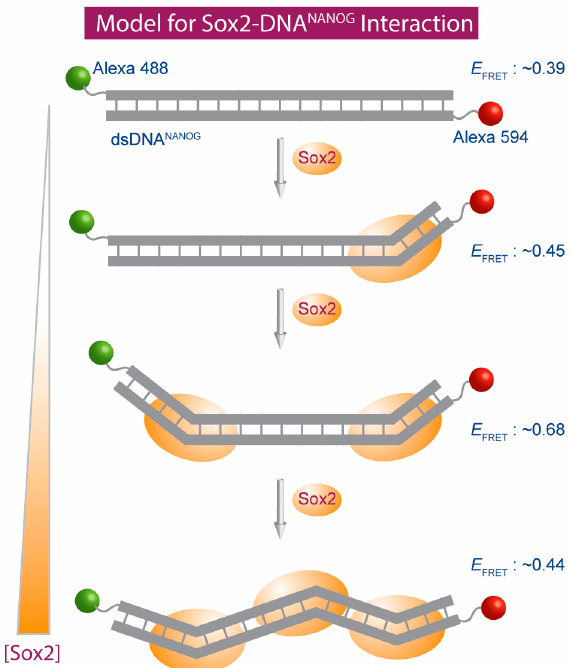
Figure 3. Schematic representation of the Sox2 stoichiometry ‐ dependent dsDNA bending transitions.